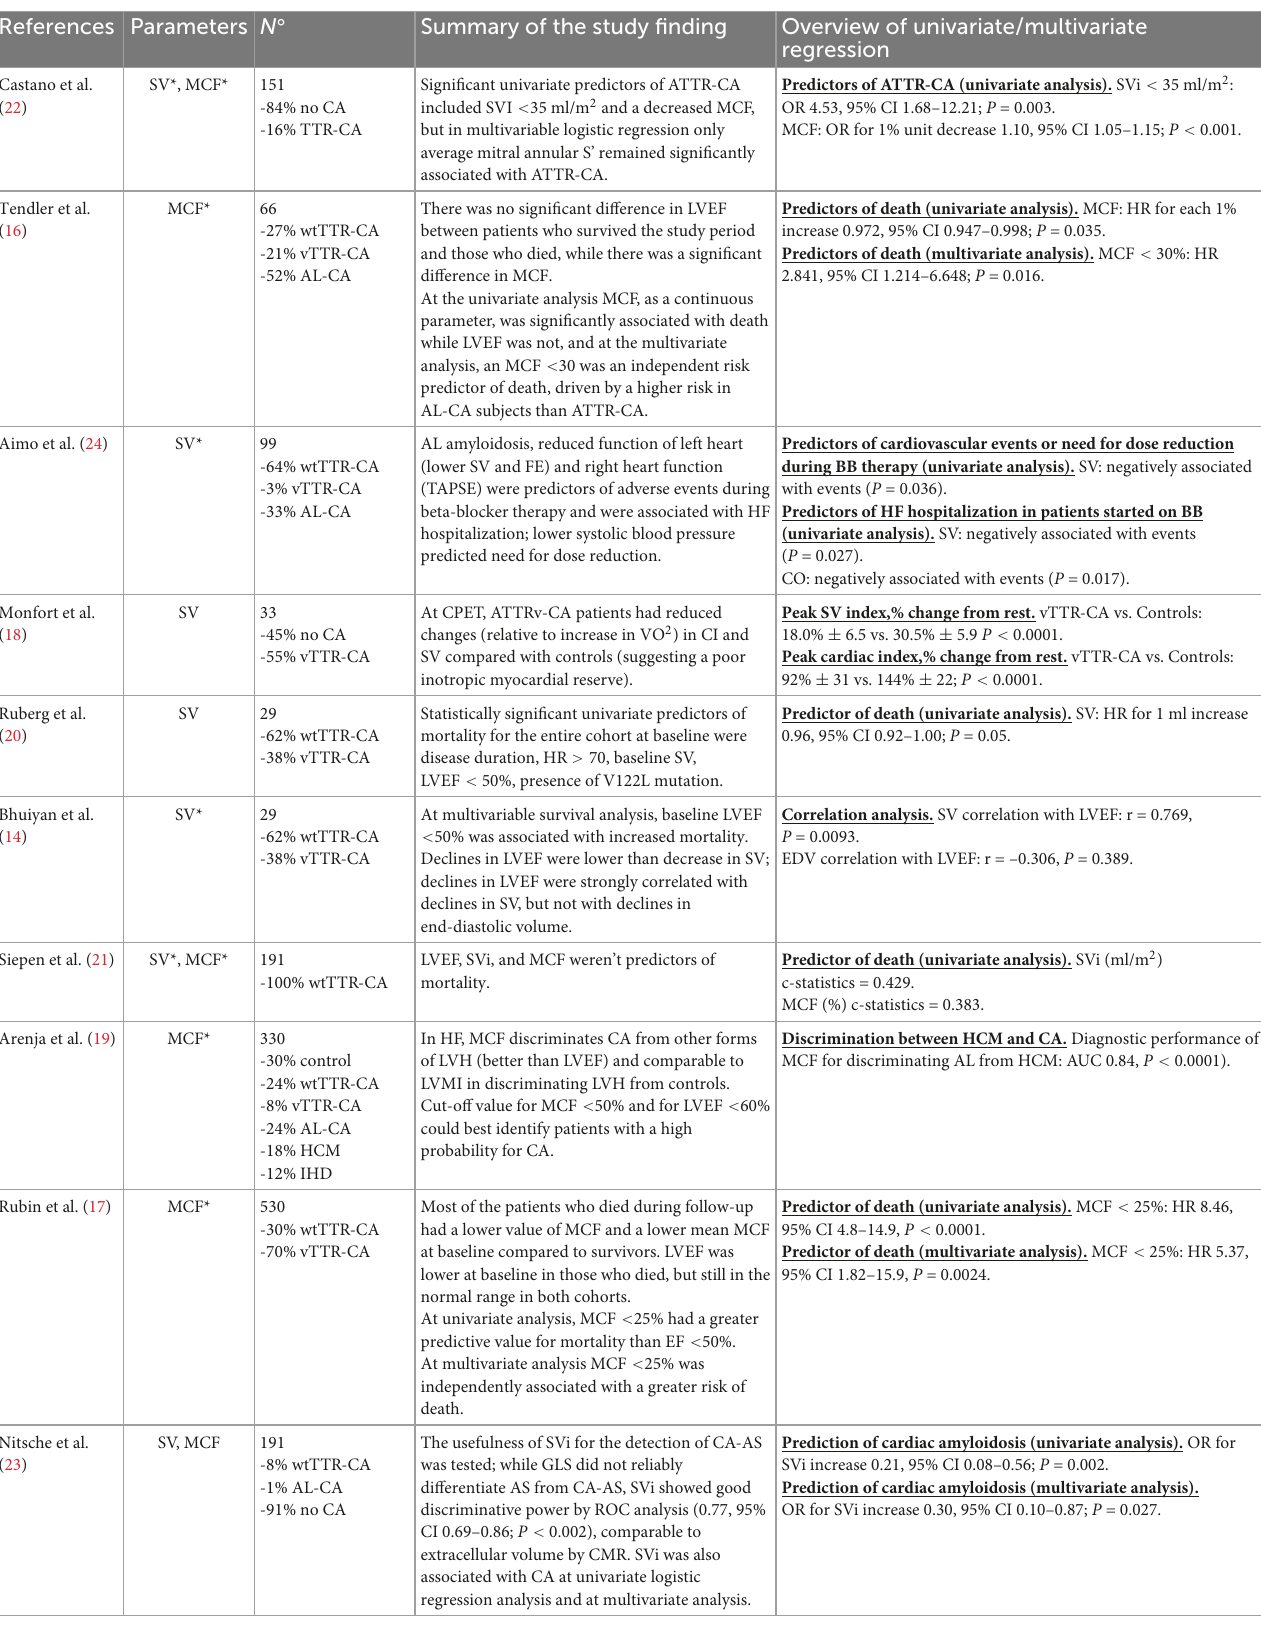
TABLE 1 Summary results of the selected